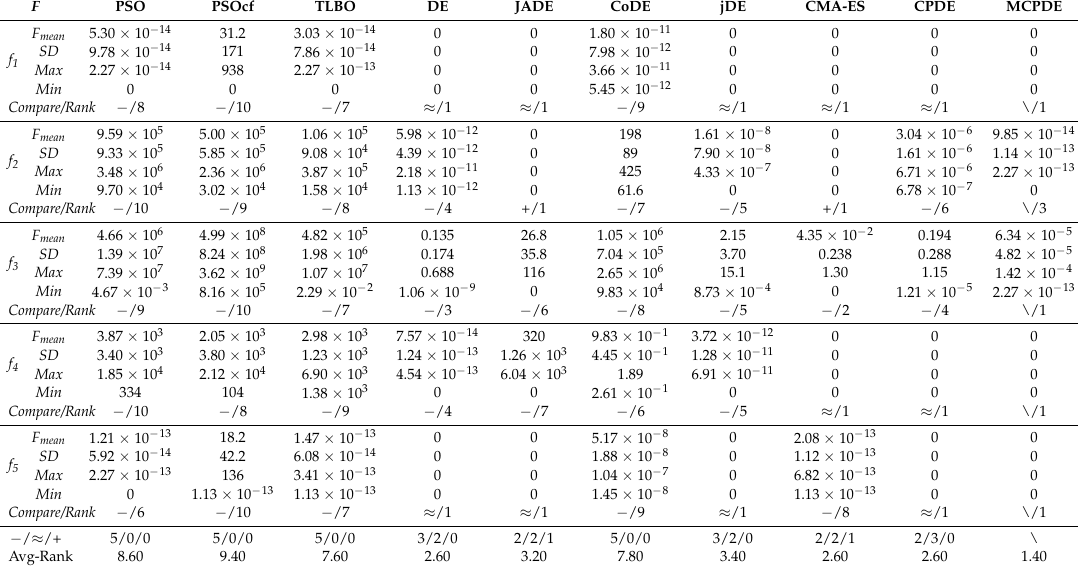
Table 1. Experimental results of PSO, PSOcf, TLBO, DE, JADE, CoDE, jDE, CMA-ES, CPDE and MCPDE over 30 independent runs on f 1 – f 5 test functions with 10 D .